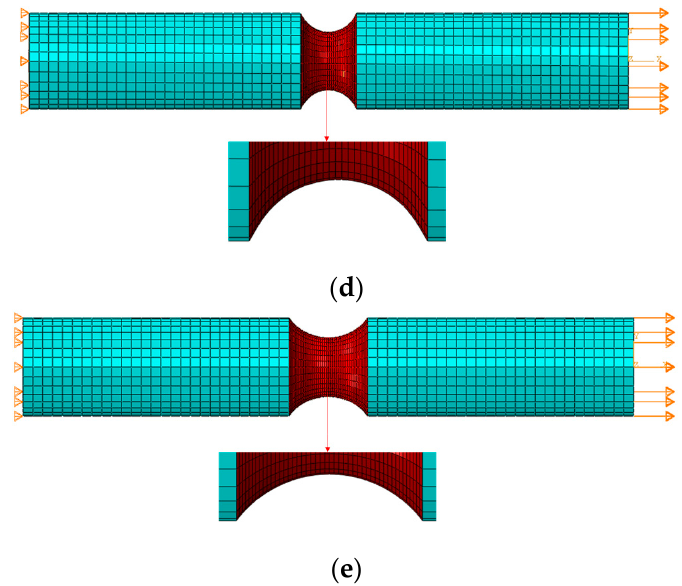
Figure 9. Finite element mesh models: ( a ) CH6; ( b ) FS; ( c ) NRB1; ( d ) NRB3; ( e ) NRB5.